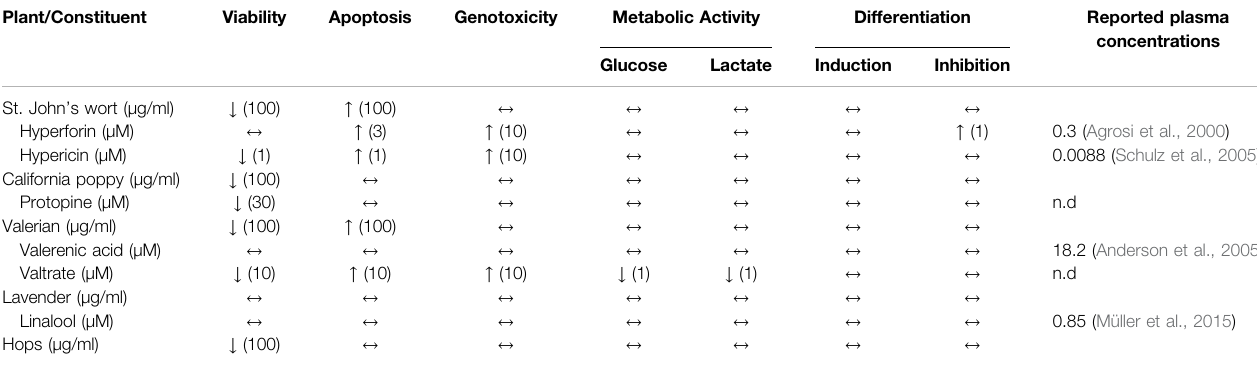
TABLE 1 | Summary of the effects a of plant extracts and their constituents on cytotoxicity, genotoxicity, metabolic activity, and their ability to induce or inhibit cell differentiation, in addition to reported plasma concentrations in literature.